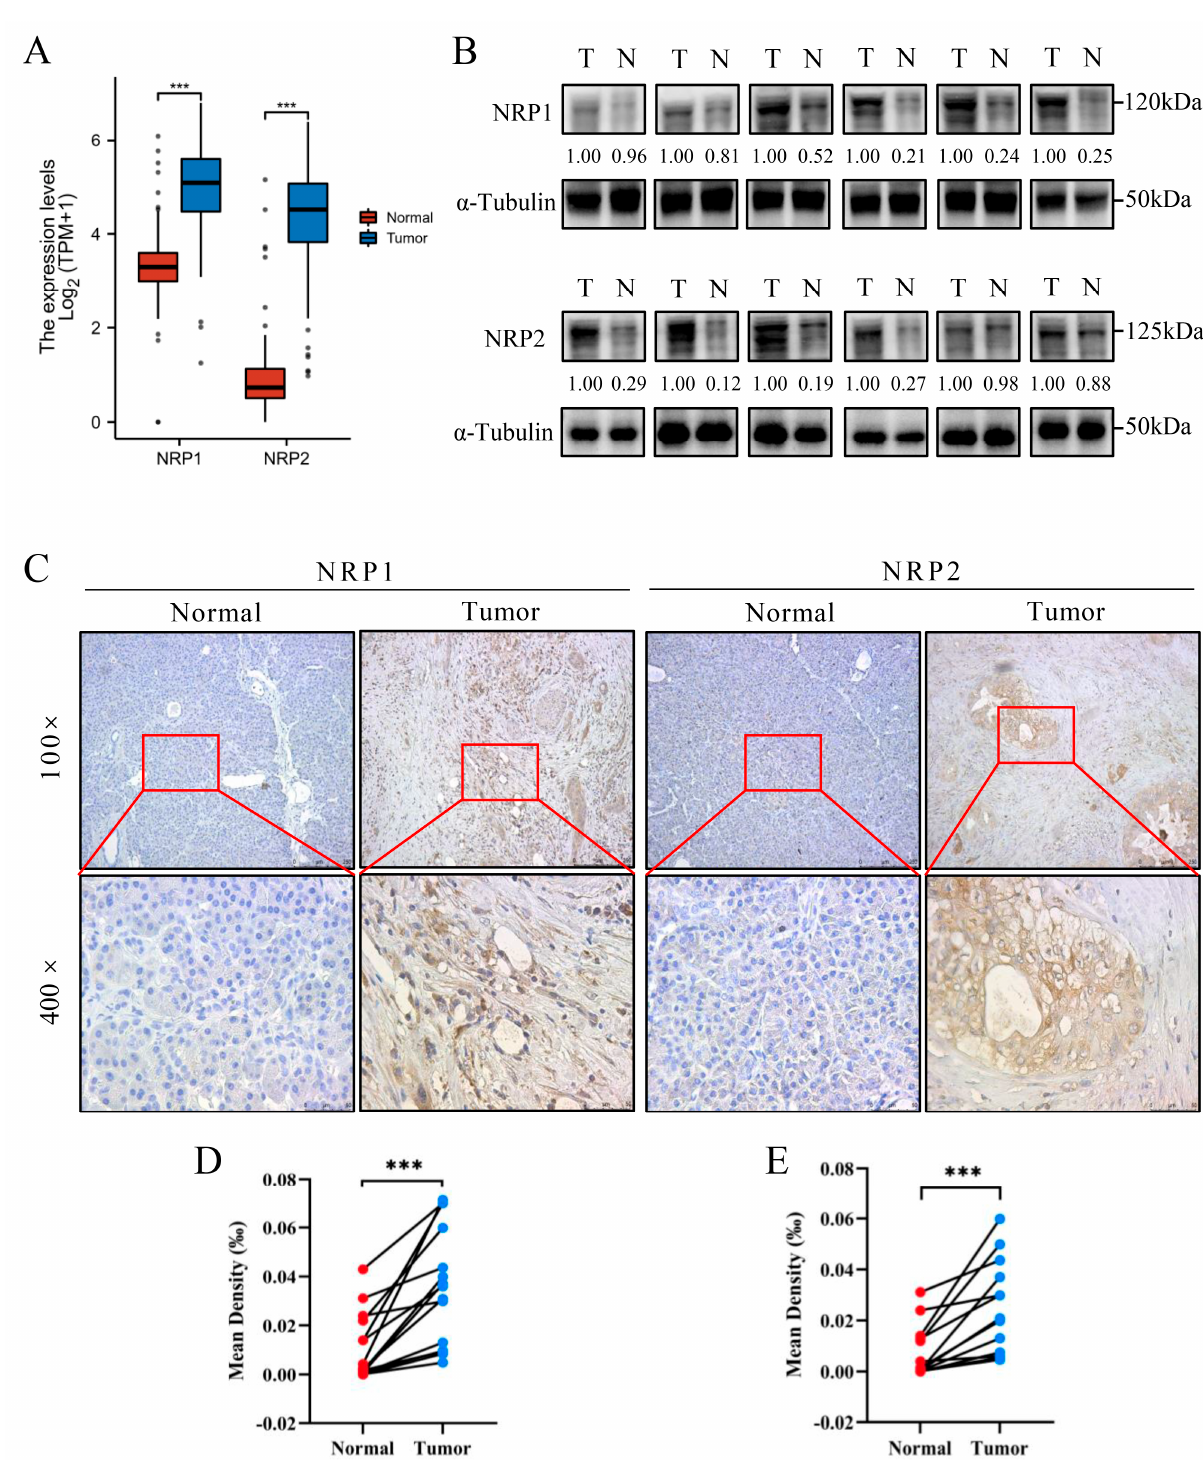
Figure 1. NRP expression in tumor tissues and normal tissues. ( A ) NRP mRNA expression between PAAD tumor tissues (179 PAAD patients) from the TCGA database and normal pancreas tissues from the TCGA (adjacent normal tissues from four PAAD patients) and GTEx databases (167 healthy people). ( B ) Western blot for NRP protein expression in fresh tumor tissues (T) and paracarcinoma (normal, N) tissues from six PAAD patients. ( C – E ) Immunohistochemistry (paraffin sections) for NRP protein expression in tumor tissues (T) and paracarcinoma (normal, N) tissues from 15 PAAD patients. *** p < 0.001. The uncropped blots are shown in Figure S8.